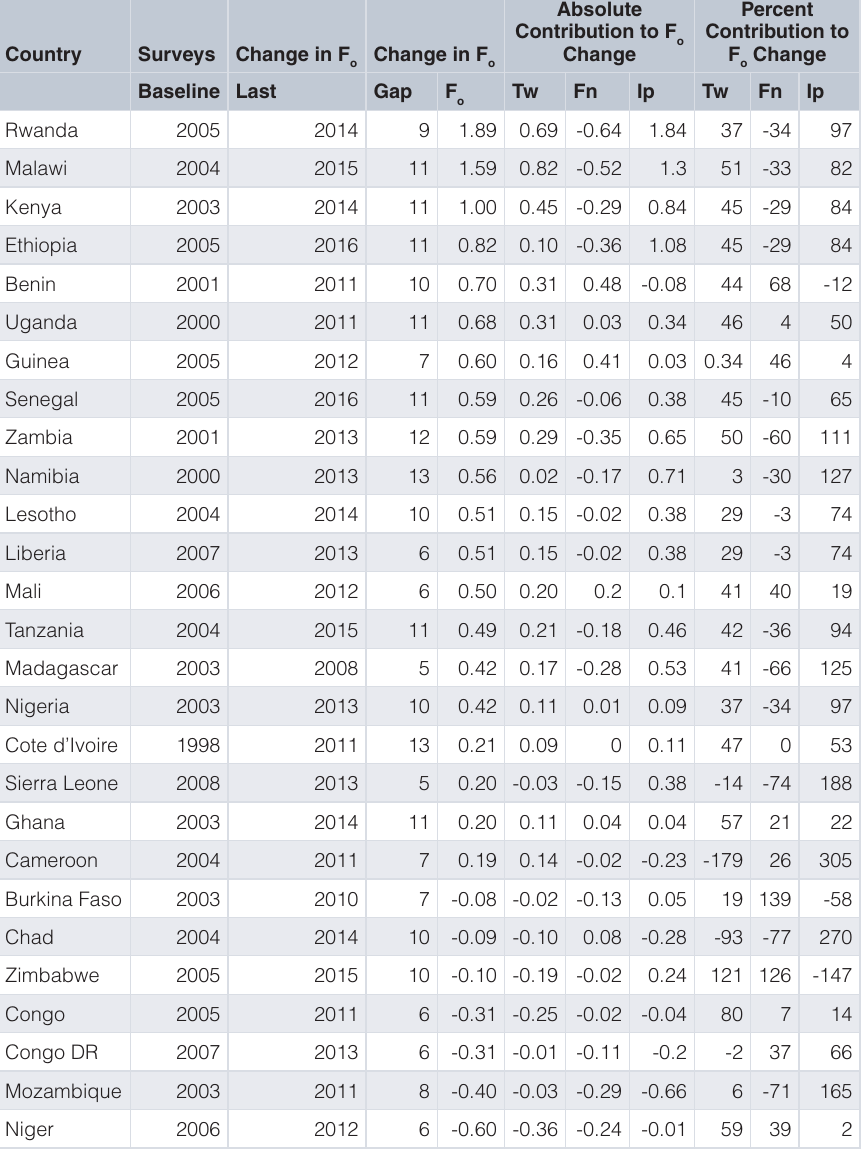
Absolute Percent Contribution to F Contribution to o Change Change in F F Change o o o